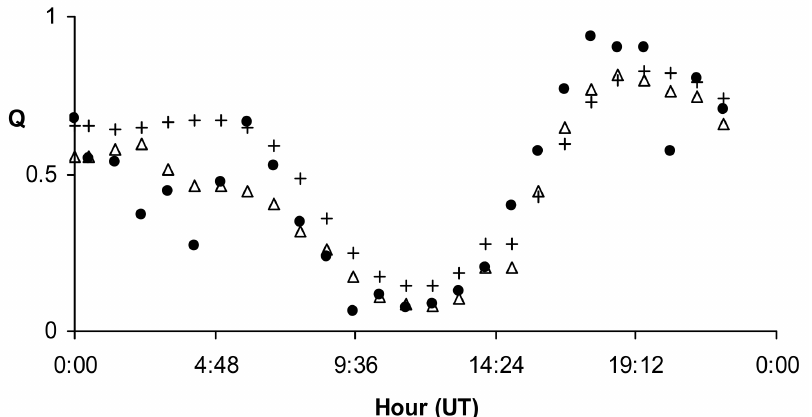
Figure 11. Allocation 34 at a threshold of 20 dB µ